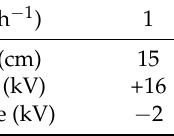
Figure 1. Scheme and picture (http://www.yflow.com) of the electrospinning set-up. Table 1. Operating conditions of the electrospinning